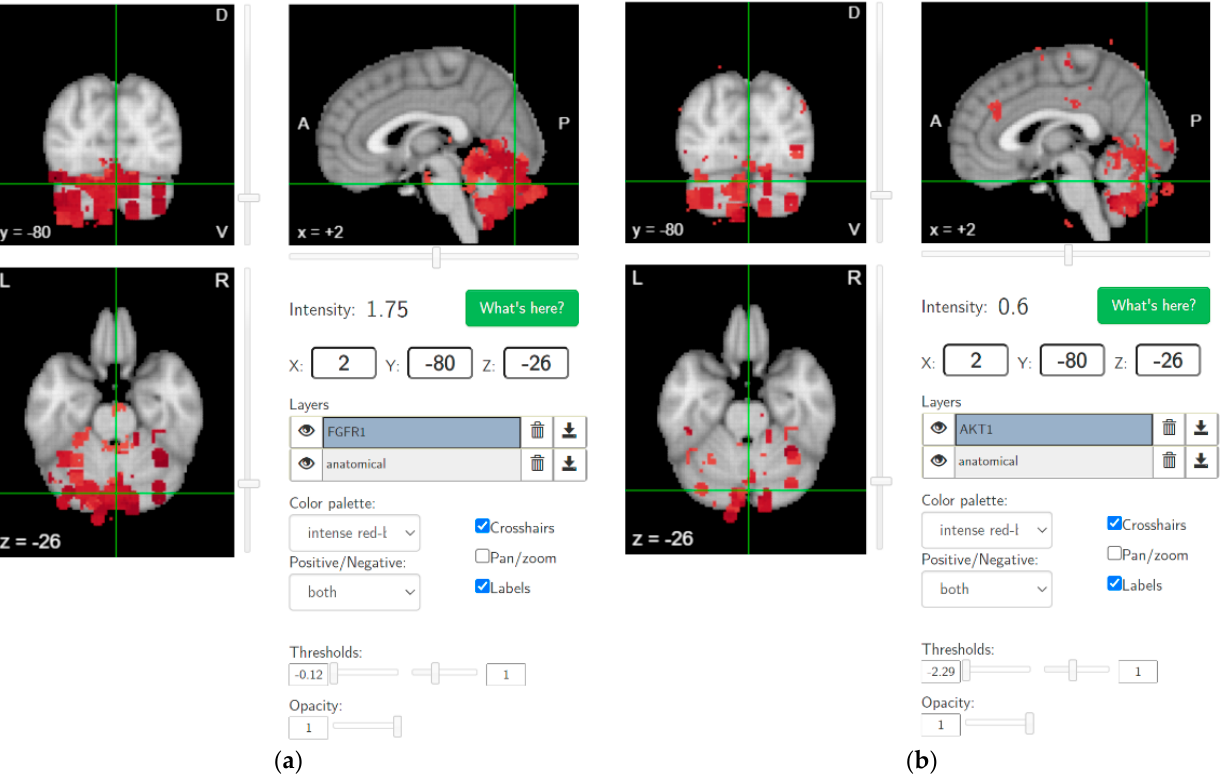
Figure 4. Brain-wide gene expression levels of ( A ) FGFR1 (thresholds: -0.12 and 1) and ( B ) AKT1 (thresholds: − 2.29 and 1), as made available by the Allen Human Brain Atlas (from https://neuro- synth.org/ accessed on 30 December 2021).